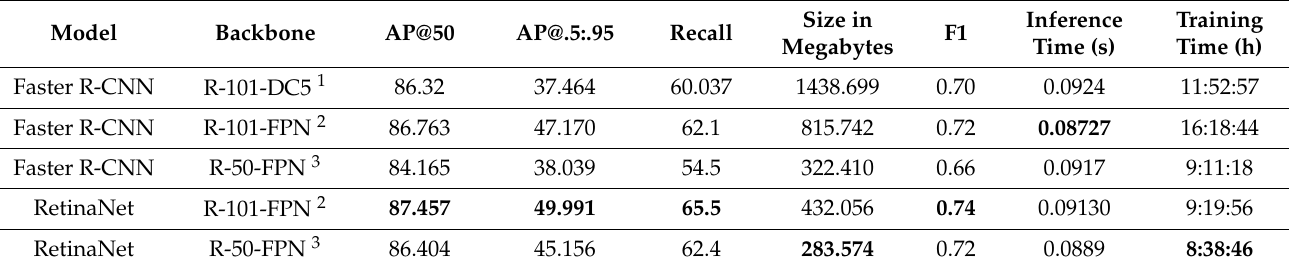
Table 7. Detecting weed growth stages using Faster R-CNN and RetinaNet.